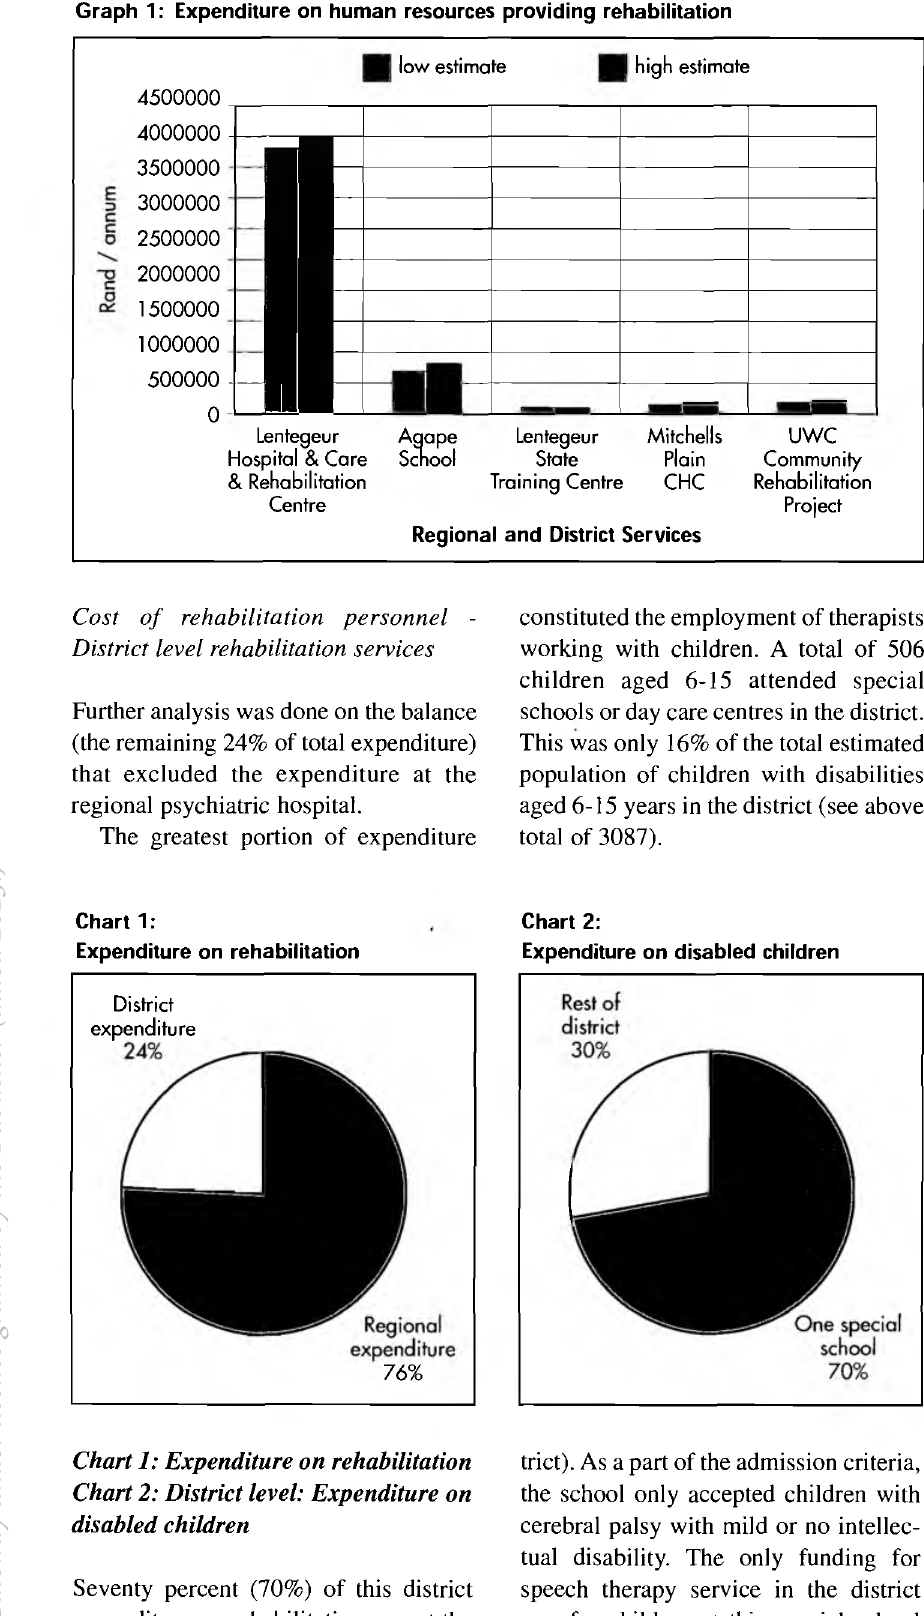
Table 2: Rehabilitation personnel